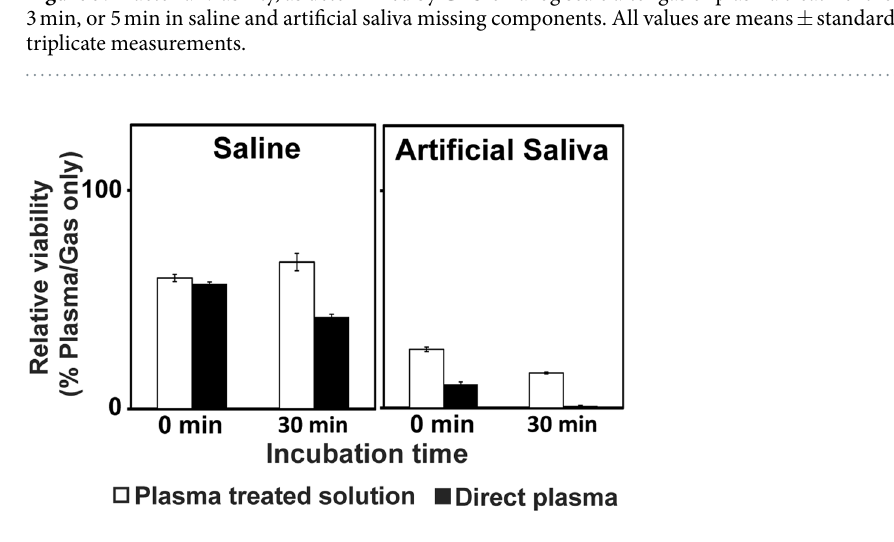
Figure 6. Inactivation of bacteria after treatment with direct plasma or plasma-exposed solutions. All treatments were performed for 5 min. Bacterial inactivation was indicated by relative viability of plasma-treated bacteria compared to gas only-treated bacteria. Relative viability (%) = (CFU after plasma treatment/CFU after gas treatment) × 100. All values are means ± standard deviations of triplicate